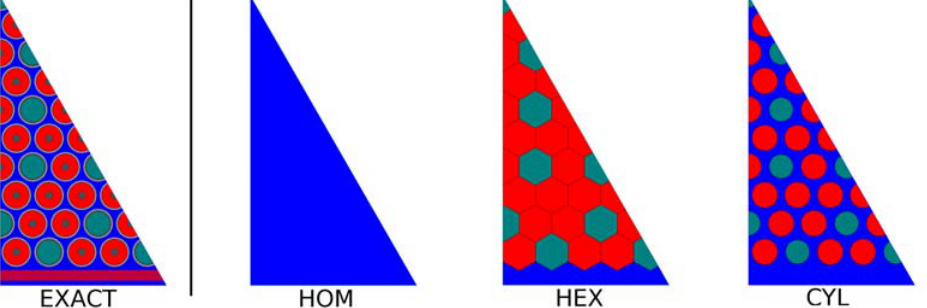
Figure 3: 2D view of exact geometry of 1/12 th of 11% Be CADOR fuel assembly (fissile zone) and its three homogenization patterns